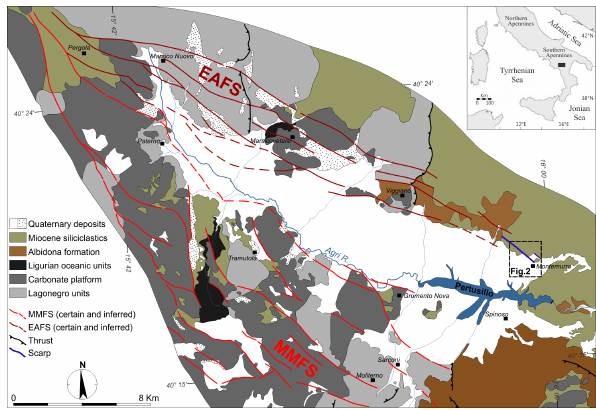
Figure 1. Schematic geological map of the High Agri